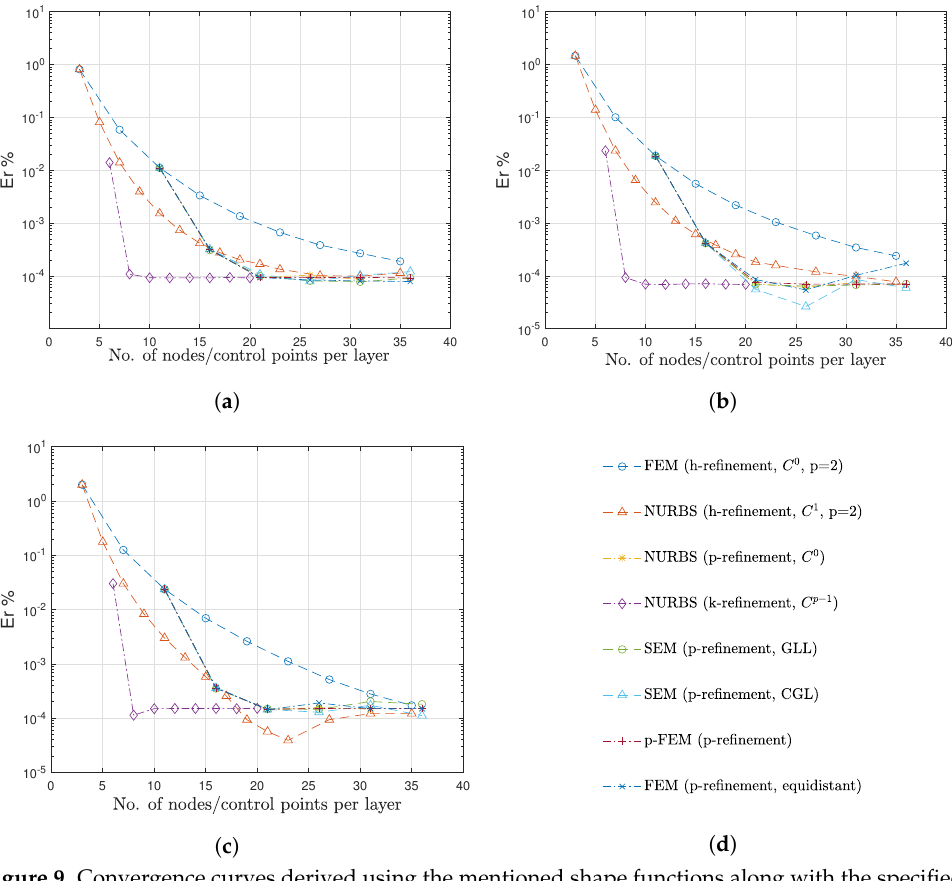
Figure 9. Convergence curves derived using the mentioned shape functions along with the specified refinement technique in the composite plate problem, ( a ) 1st mode, ( b ) 2nd mode, ( c ) 3rd mode, ( d )